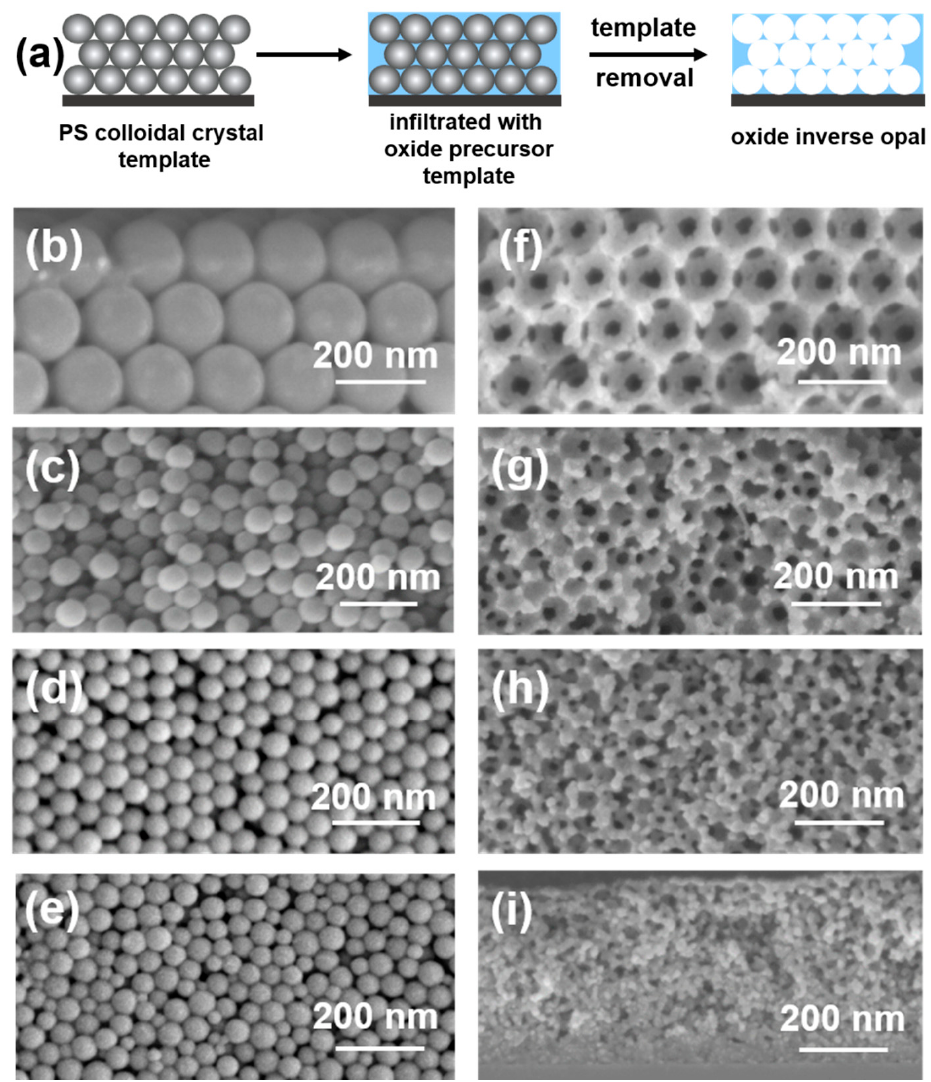
Figure 1. ( a ) Schematic representation of template-based ZnO inverse opal formation. ( b – e ) SEM images of polystyrene (PS) template films ( b ) PS175-T, ( c ) PS70-T, ( d ) PS60-T, and ( e ) PS48-T. ( f – i ). Cross-section SEM images of the corresponding porous ZnO IO films obtained after three ZnO deposition cycles and extraction with toluene at 60 °C. ( f ) Z175-IO, ( g ) Z70-IO, ( h ) Z60-IO, and ( i ) Z48-IO.